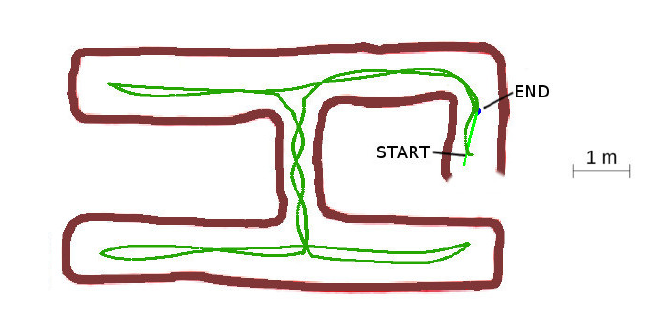
Figure 21. Acyclic